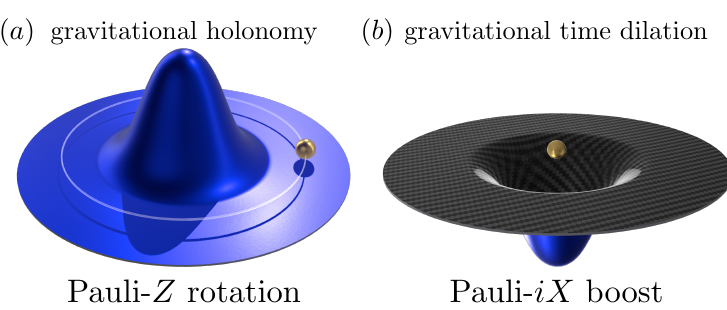
Figure 1: (a) Particle (sphere) encircling a curvature bulge (or dent) may be used for realizing a Pauli- Z gate. (b) Particle (sphere) spending time in a curvature dent (or bulge) may be used for realizing a Pauli- iX